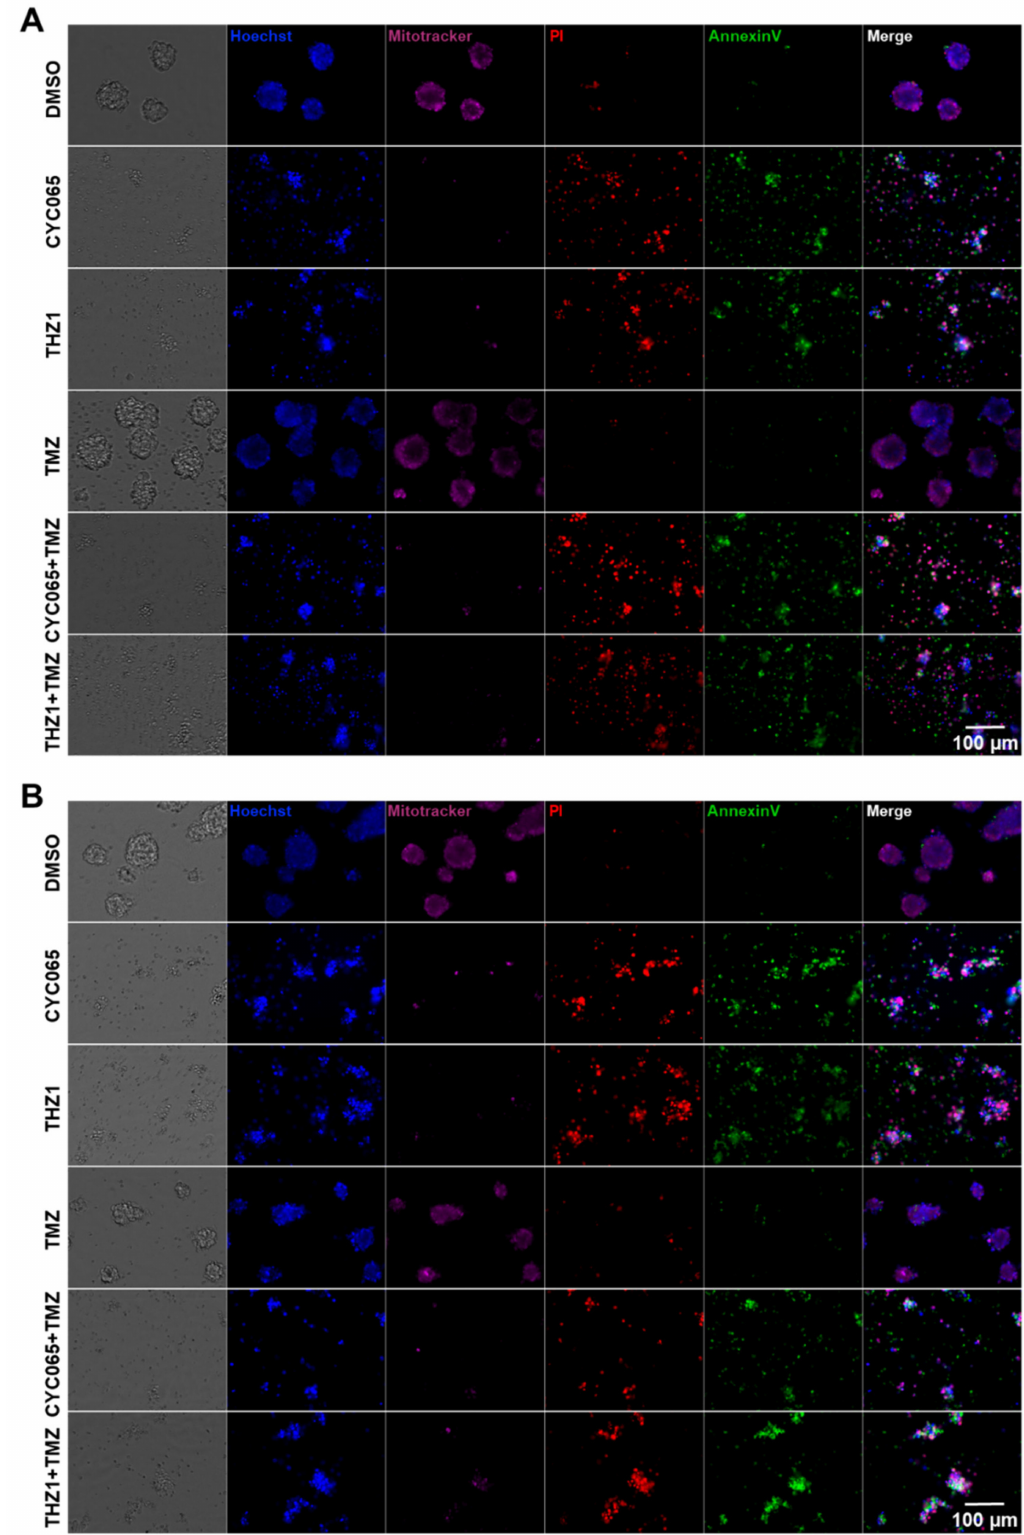
Figure 6. CYC065 and THZ1 induce apoptotic cell death in CD133 and CD44-positive GSC subpopulations in recurrent GTCC-10 gliomaspheres. ( A ) CD133-positive subpopulation of GTCC-10 gliomaspheres and ( B ) CD44-positive subpopula- tion of GTCC-10 gliomaspheres. Sorted subpopulations were treated with DMSO, 150 µ M TMZ, 3 µ M CYC065 or 100 nM THZ1 alone or pre-treated with TMZ (150 µ M, 24 h) and imaged 120 h after treatment. Images were taken using Nikon Eclipse TE2000 microscope; scale bar = 100 µ m; n = 3 independent experiments were